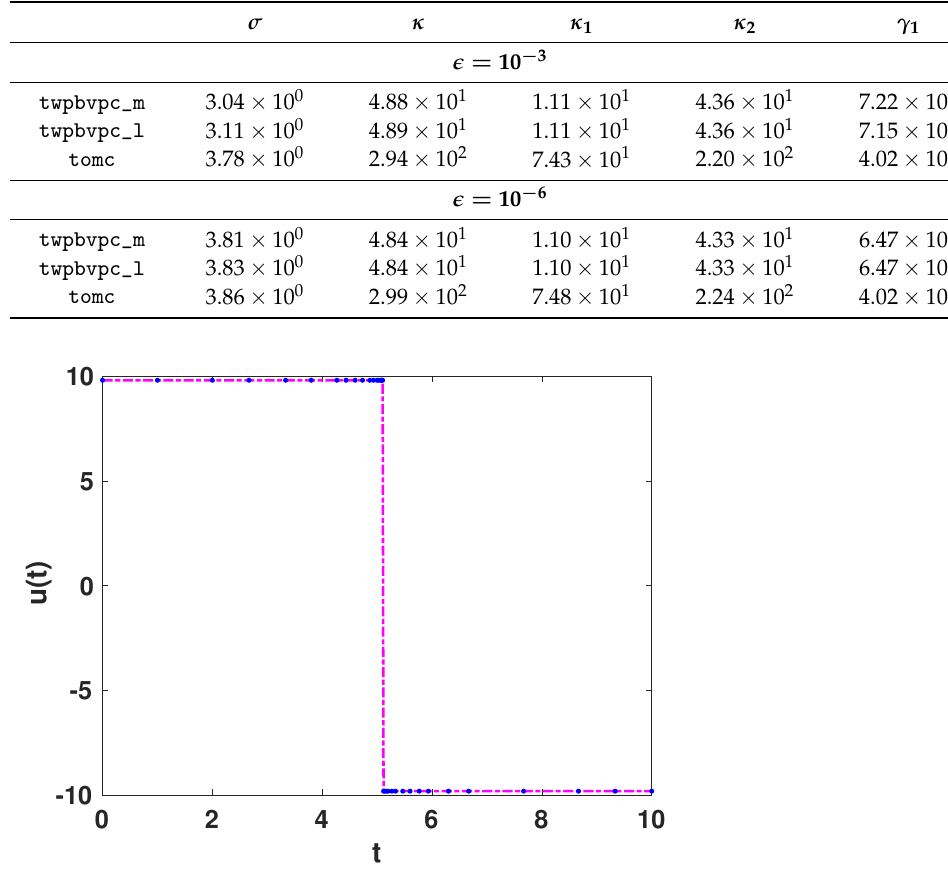
Figure 4. Longitudinal dynamics of a vehicle, (cid:101) = 10 − 3 , T = 10, g = 9.81, k 0 = 0.02 g , k 1 = 10 − 5 g , k 2 = 0, k 3 = 0: theoretical (dash-dot line) and numerical (dot line) solution in time for the control u